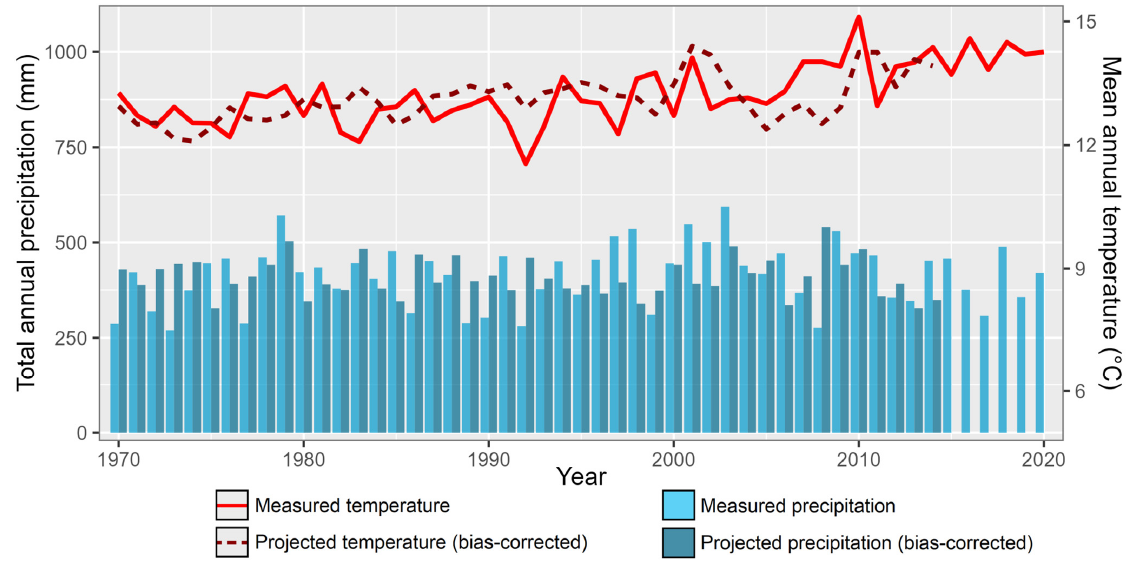
Figure 7. Annual mean air temperature and annual total precipitation for the period 1970–2014; projected (bias-corrected) air temperature and precipitation values for 1970–2020.